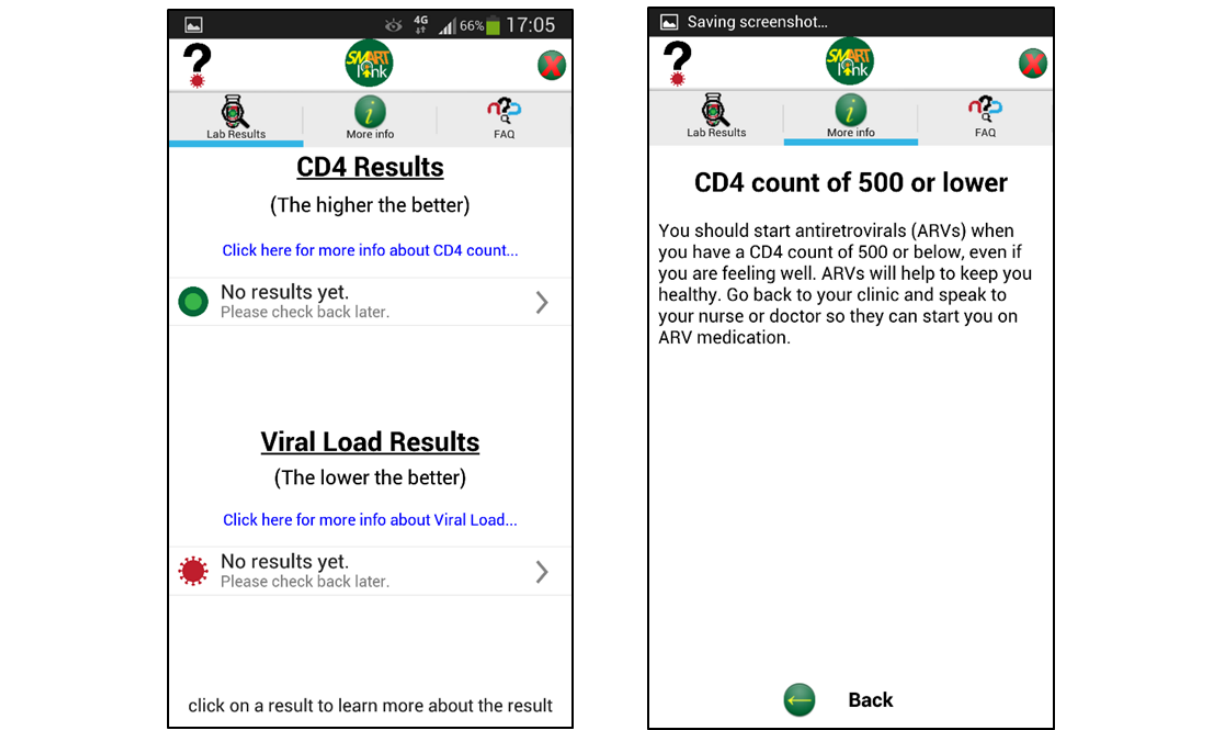
Figure 2. Screenshots of the SmartLink app, illustrating the results format and an example of advice